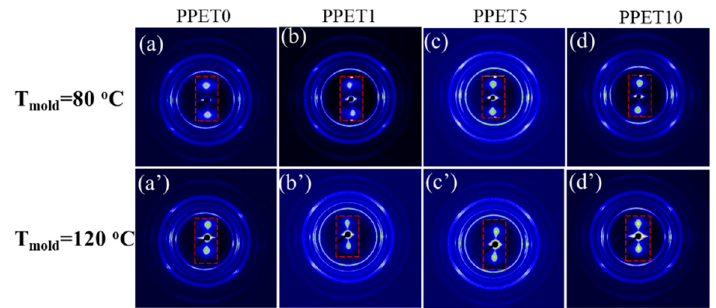
Figure 9. The two dimensional wide-angle X-ray diffraction (2D-WAXD) reflection patterns of the M-parts.